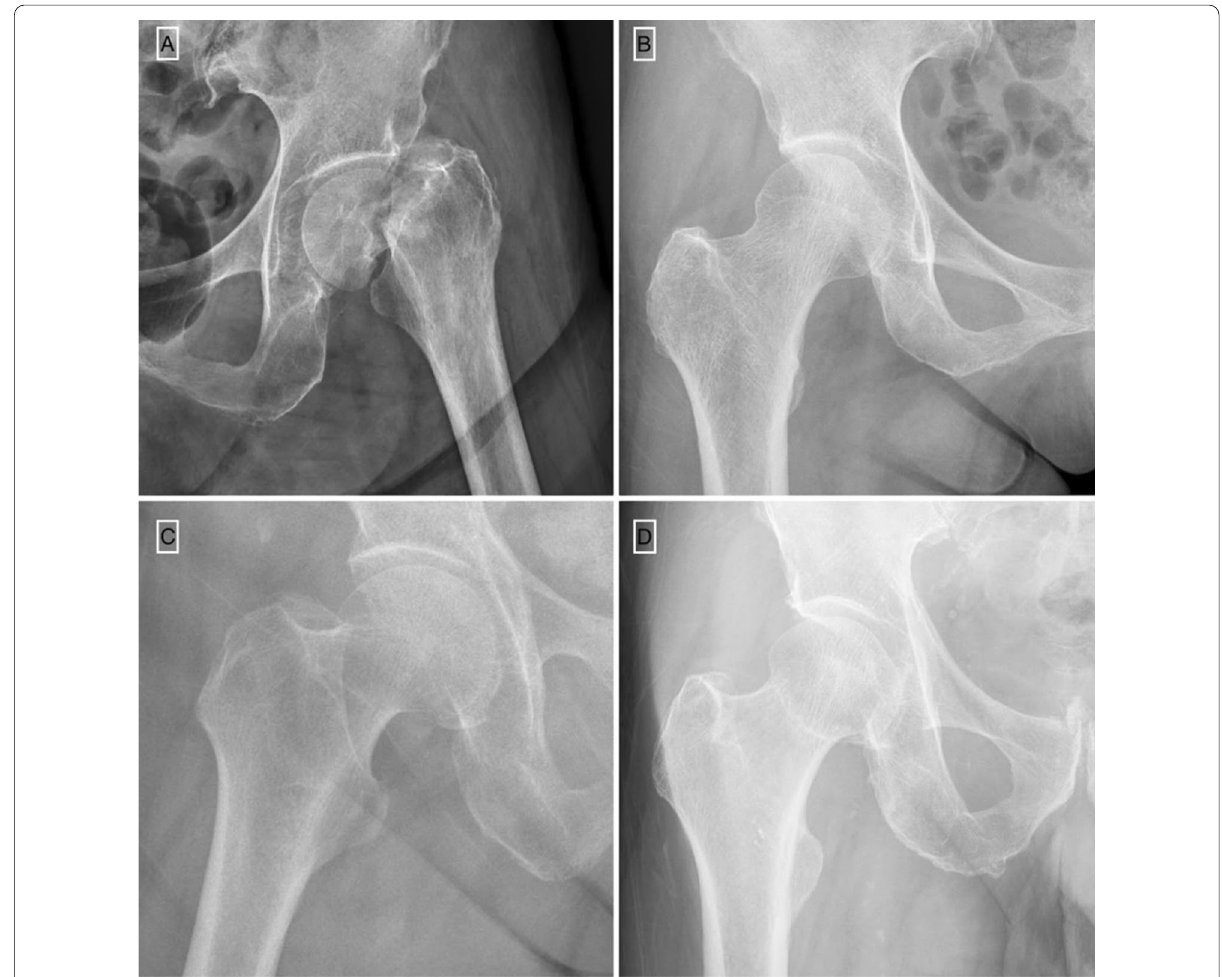
Fig. 2 Sample X‑ray images of different diagnosis rates. A : The significant hip fracture with a high detection rate of 98.3%; B The normal and healthy hip with 98.9% correct rejection; C The non‑fracture hip but the sclerotic line causes a high false positive rate, 67.4%; and D An occult hip fracture without displacement. The correction detection of fracture is only